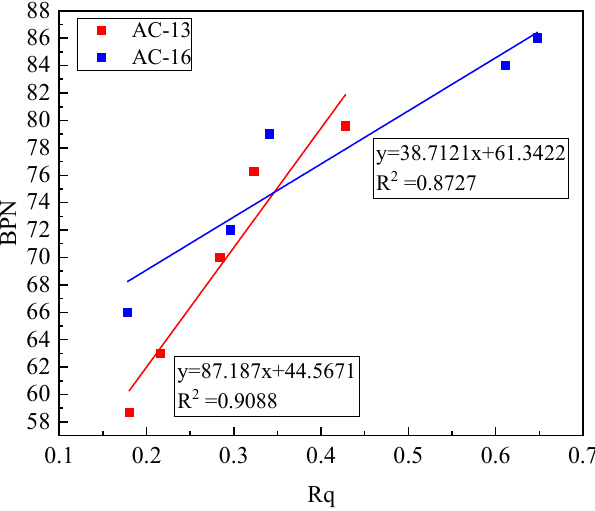
Figure 15. Relationship between BPN and Rq.